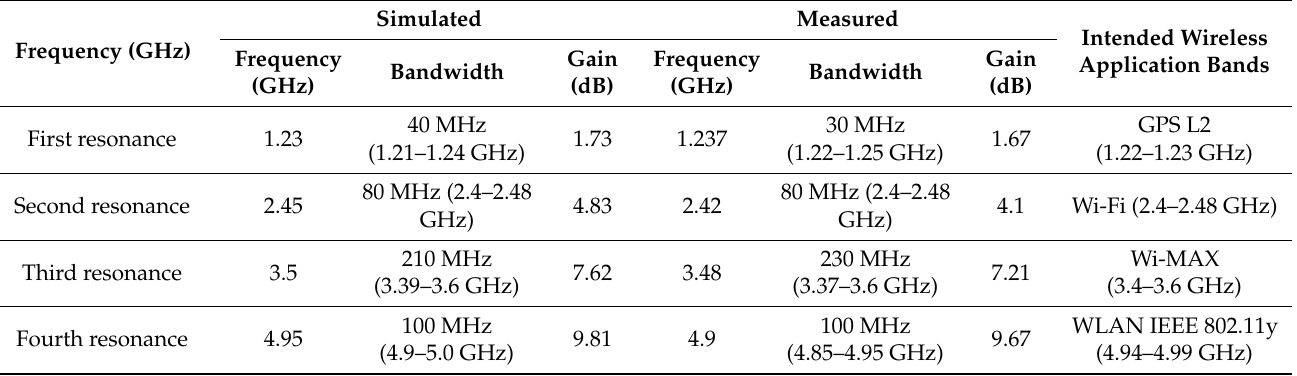
Table 5. Comparison table of measured and simulated antenna parameters of the four element MIMO antenna.